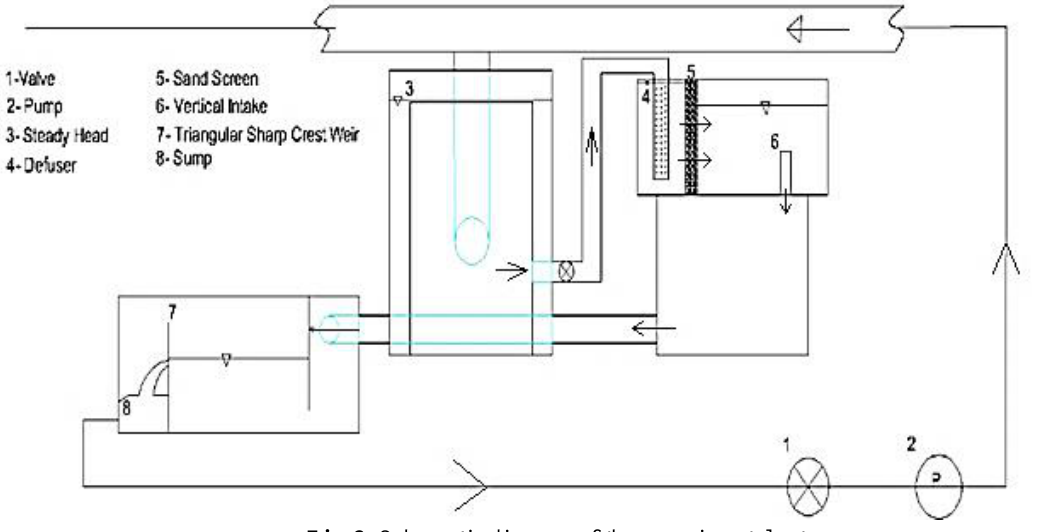
Fig. 3 Schematic diagram of the experimental